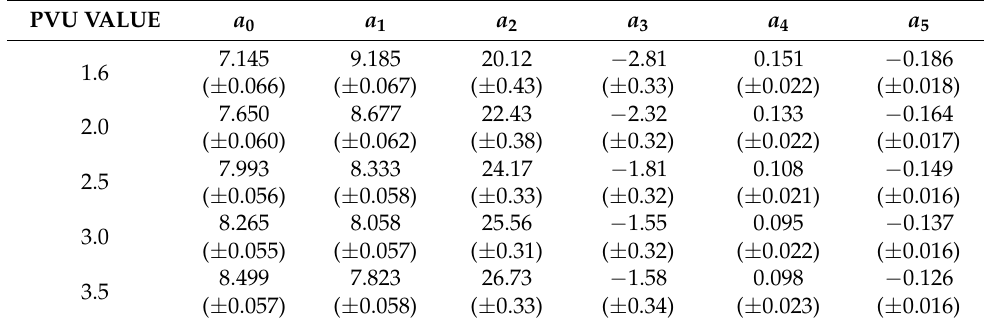
Table 3. Coefficients ( a 0 − 5 ) estimated for Northern Hemisphere, see Equation